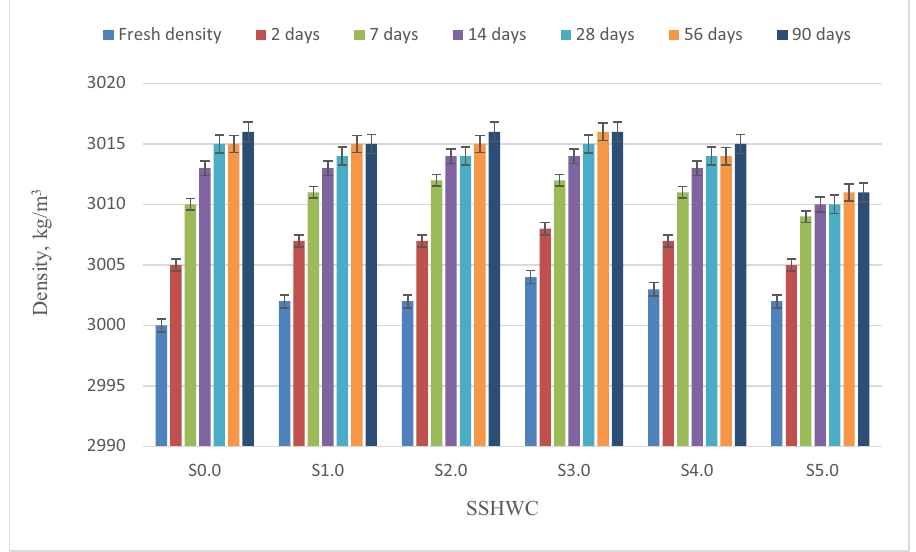
Figure 7: Fresh and hardened density of